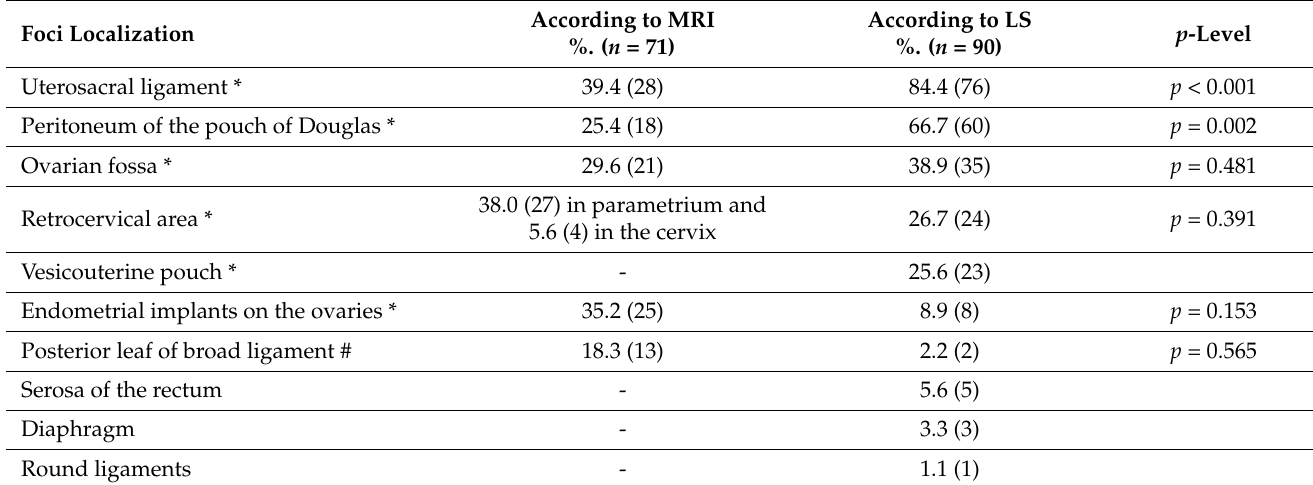
Table 4. Localization of endometriotic foci according to MRI and laparoscopy (LS) in the study’s sample. According to Foci Localization